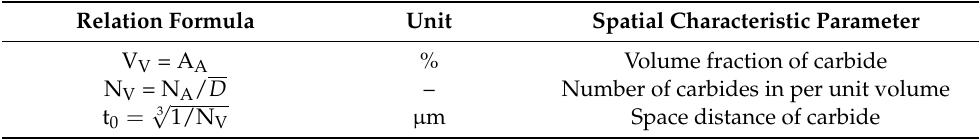
Table 5. The basic relation between the microstructure characteristic parameters. Relation